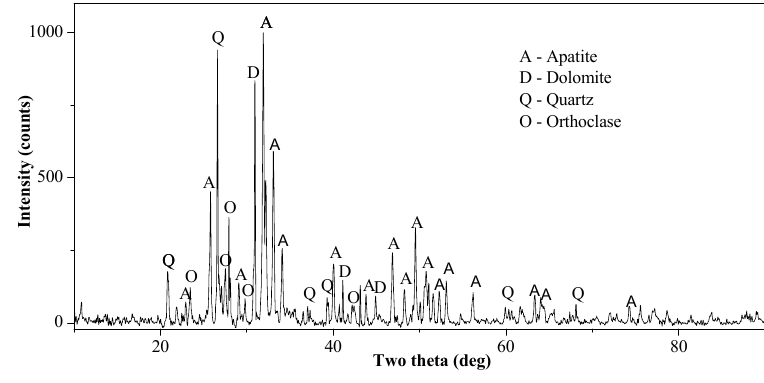
Figure 2. X-ray diffraction (XRD) image of raw ore.